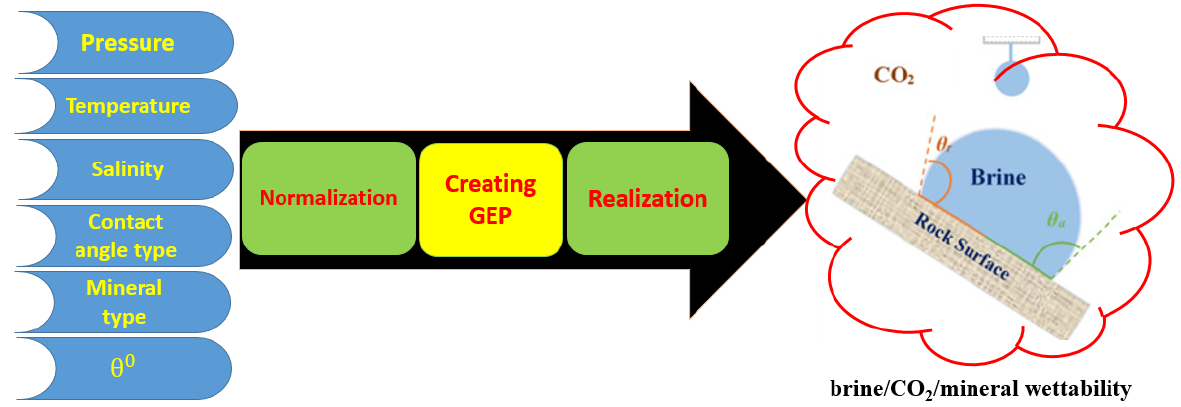
Figure 2. An illustration of the methodology used in this study.